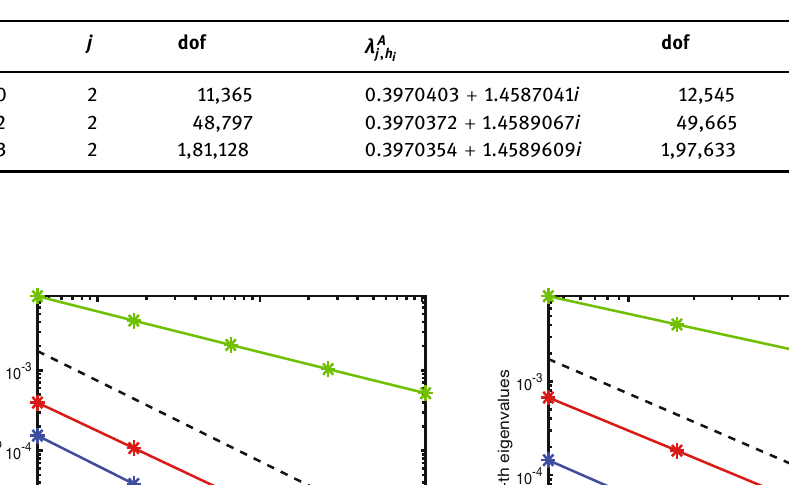
Table 2: The second eigenvalue for ( 2.1 ) – ( 2.2 ) : L - shaped domain ( k = 1, n ( x ) = 4 + 4 i )